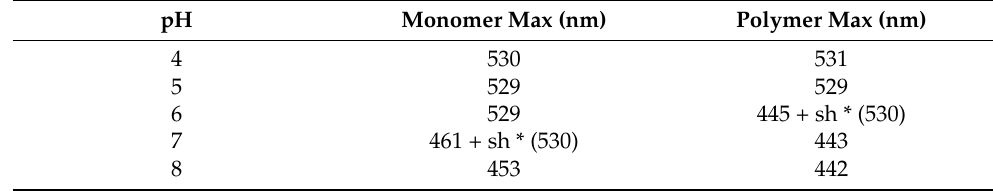
Table 3. Positions of band maxima of monomeric and polymeric forms of NR as a function of pH.